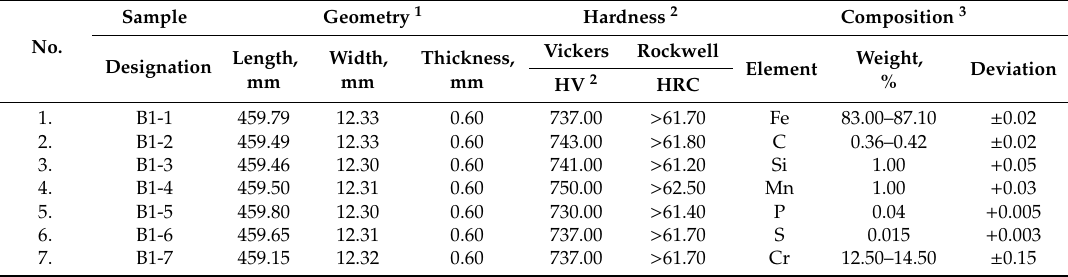
Figure 2. Example planar cutting blade used in the experimental studies. Table 1. Dimensional characteristic and elemental composition of X39Cr13-base planar cutting blades used in experimental studies.